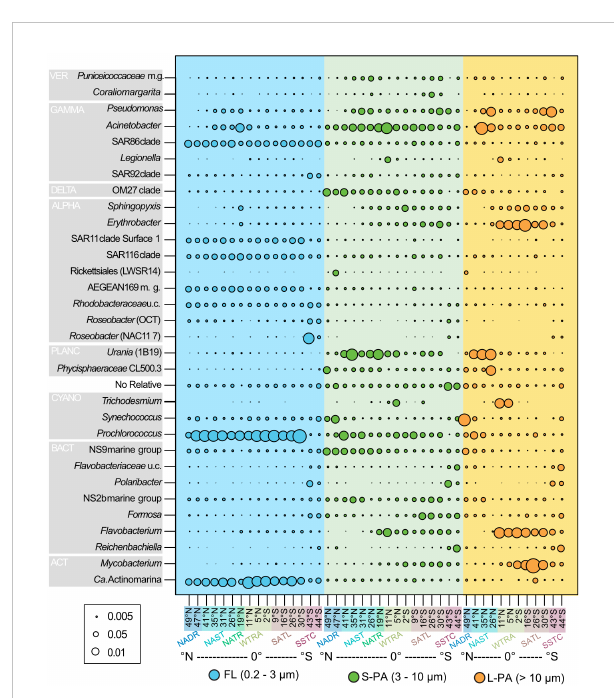
FIGURE 4 Bubble plot of bacterial taxa that reached a minimum of 5% relative read abundance from samples taken across the Atlantic Ocean during the AMT22 cruise in 2012. Colors indicate the size fraction: Blue free-living (FL), green small particle-attached (S-PA), and orange large particle-attached (L-PA) fraction. ACT Actinobacteria, ALPHA Alphaproteobacteria, BACT Bacteroidetes, CYANO Cyanobacteria, DELTA Deltaproteobacteria, GAMMA Gammaproteobacteria, PLANC Planctomycetes, VER Verrucomicrobia. NADR North Atlantic Drift, NAST North Atlantic Subtropical, NATR North Atlantic Tropical Gyre, WTRA Western Tropical Atlantic, SATL South Atlantic Gyre, and SSTC South Subtropical